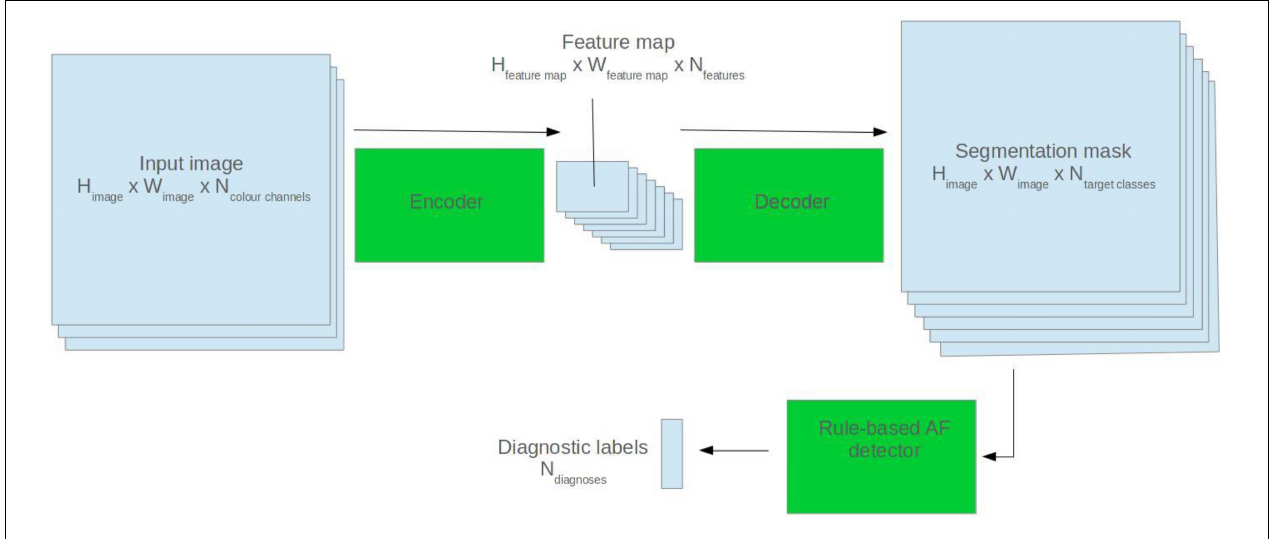
FIGURE 2 | Visualisation of the rule-based AF detector.